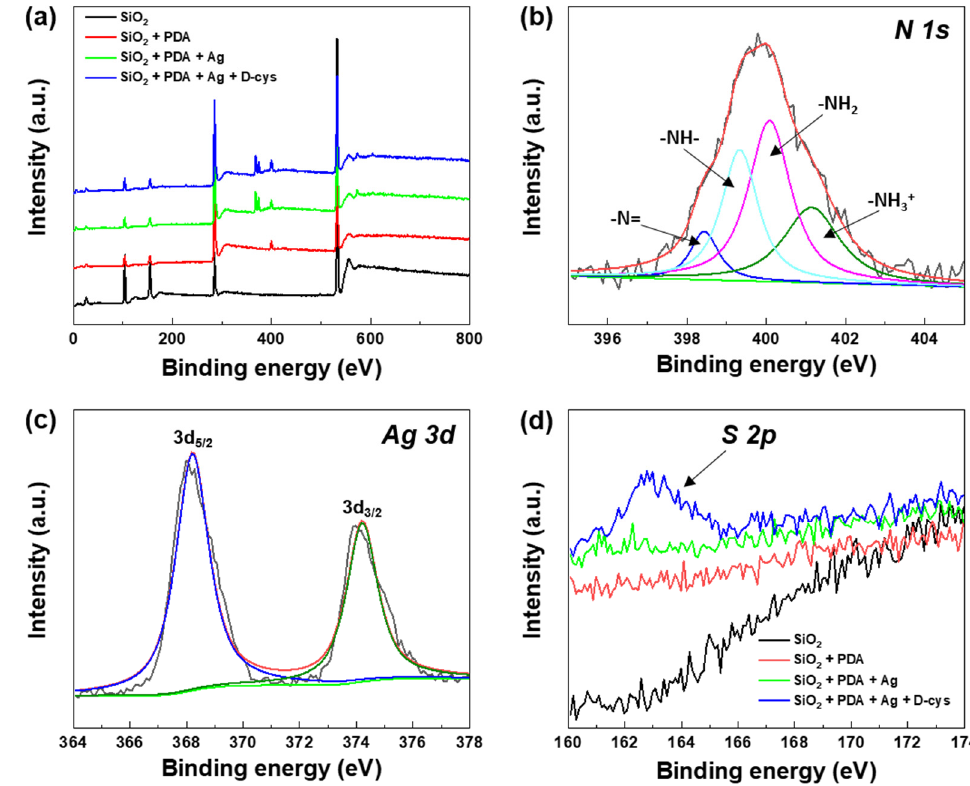
Figure 4. XPS spectra of ( a ) wide scans, ( b ) N 1s, ( c ) Ag 3d, and ( d ) S 2p of the antibacterial nano- particles.